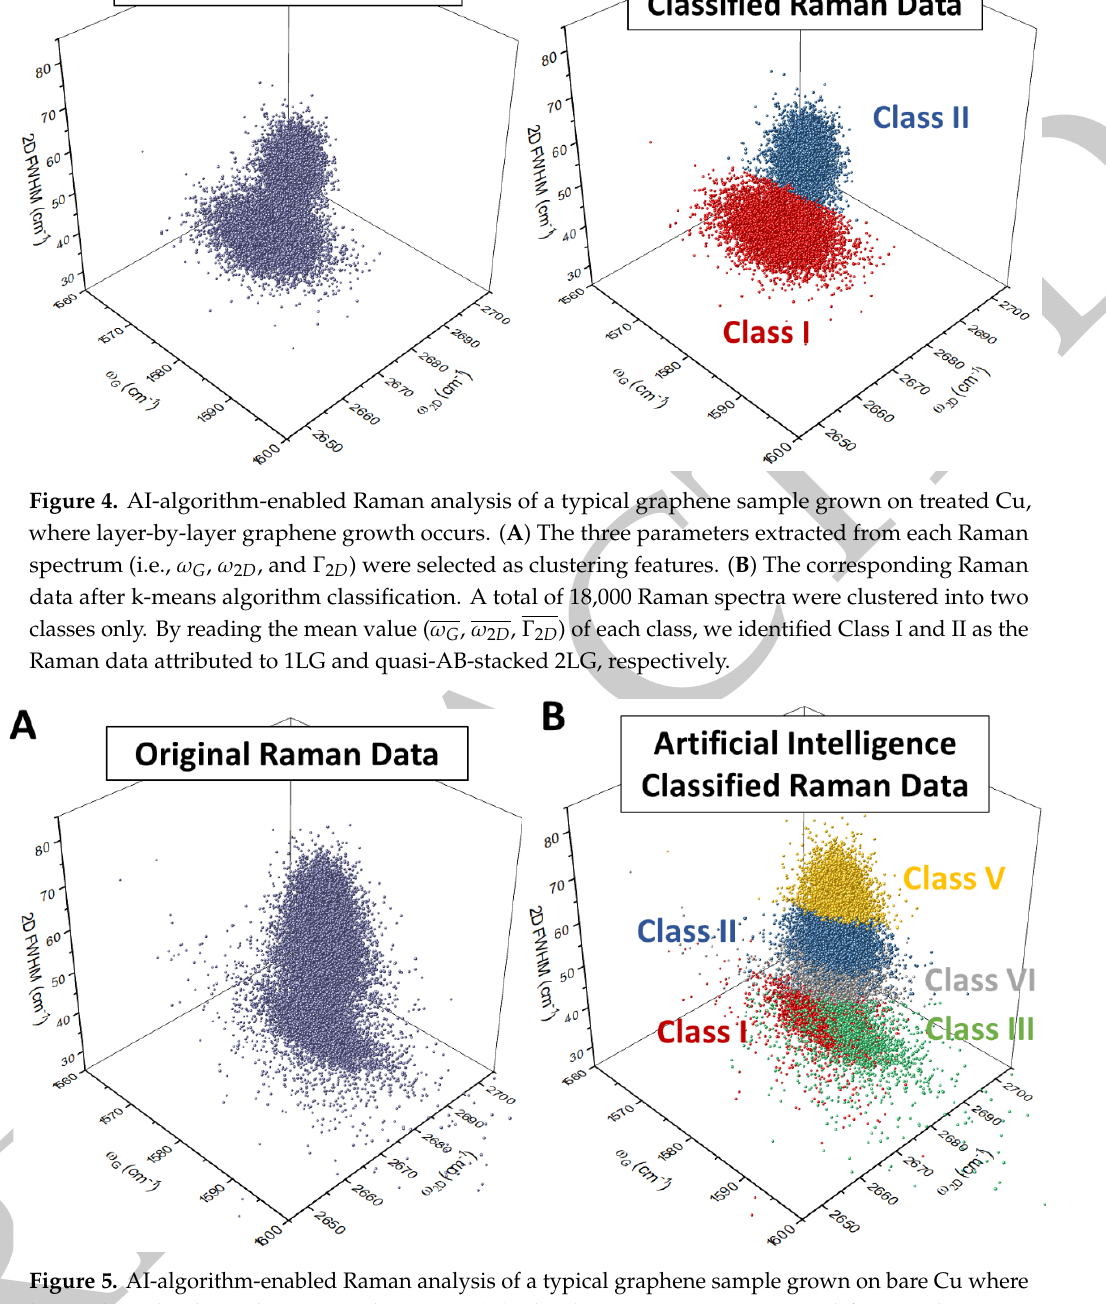
Figure 5. AI-algorithm-enabled Raman analysis of a typical graphene sample grown on bare Cu where layer-plus-island graphene growth occurs. ( A ) The three parameters extracted from each Raman spectrum (i.e., ω G , ω 2 D , and Γ 2 D ) were selected as clustering features. ( B ) The corresponding Raman data after k-means algorithm classification. By reading the mean value ( ω G , ω 2 D , Γ 2 D ) of each cluster, we identified Class I to V as the Raman data attributed to 1LG, quasi-AB-stacked 2LG, larger-twisting-angle 2LG, 3LG, and MLG, respectively.